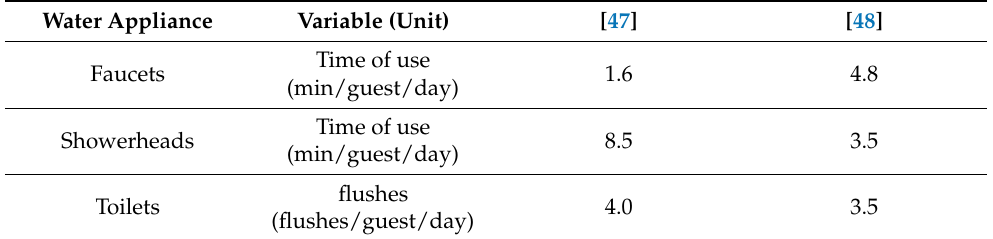
Table 4. Average use-time (faucets and showerheads) and number of uses (toilets) per